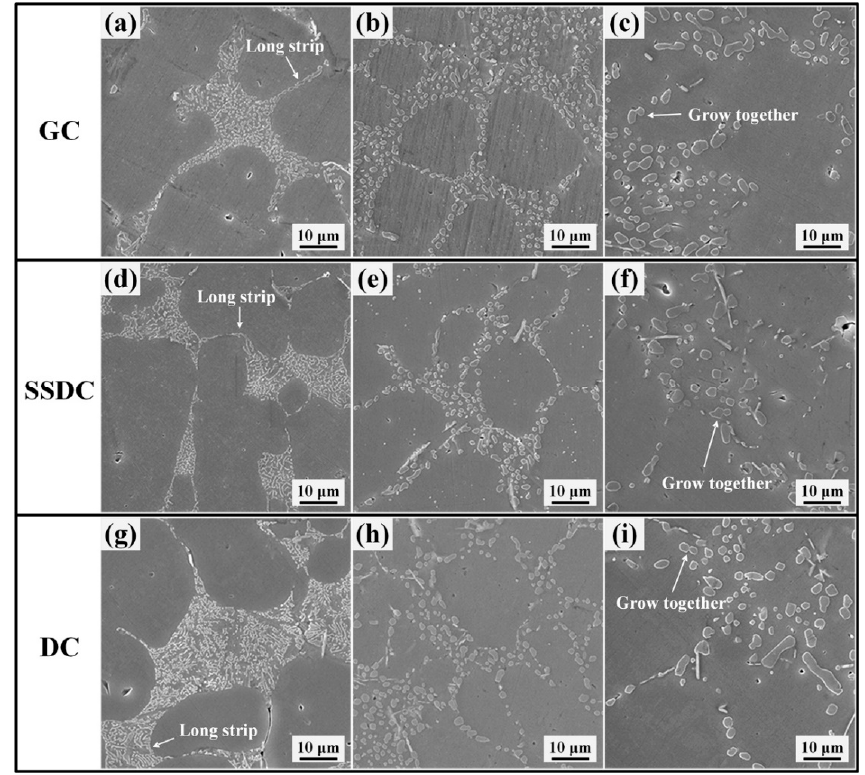
Figure 2. SEM of alloy GC ( a ) as-cast ( b ) ST6 ( c ) LT6, alloy SSDC:( d ) as-cast ( e ) ST6 ( f ) LT6,and alloy DC: ( g ) as-cast ( h ) ST6 ( i ) LT6. ( i )